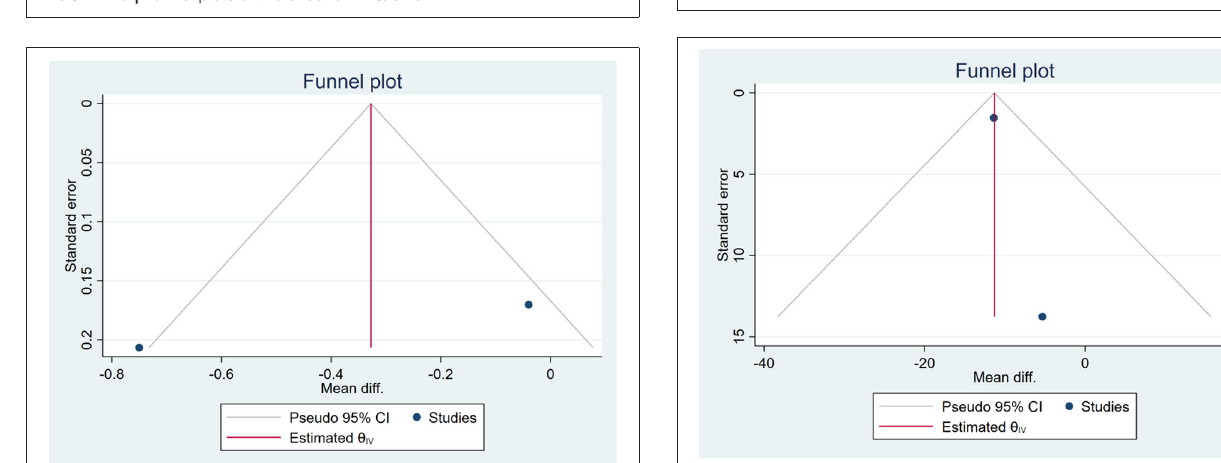
FIGURE 24 | Funnel plots of the effect of AST.